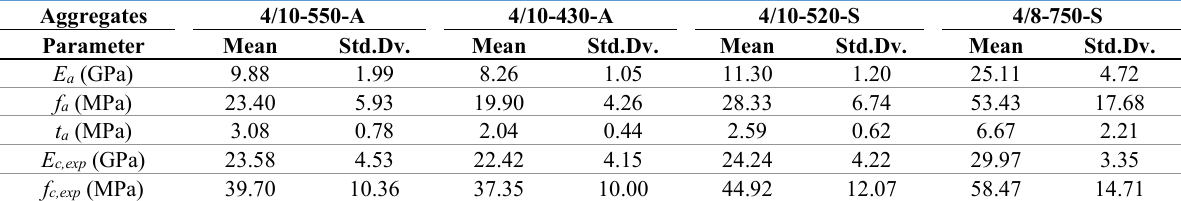
Table 2 P roperties of the aggregates used in the numerical simulation Aggregates 4/10-550-A 4/10-430-A 4/10-520-S Parameter Mean Std.Dv.